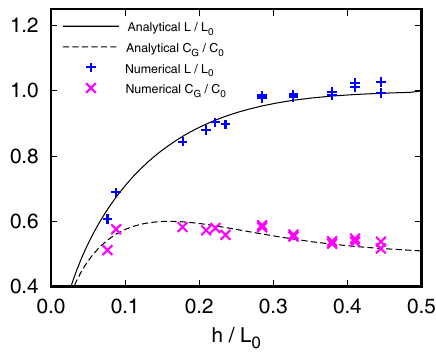
Figure 9. Variation of wave dispersion parameters L / L 0 and C G / C 0 for h / L 0 .